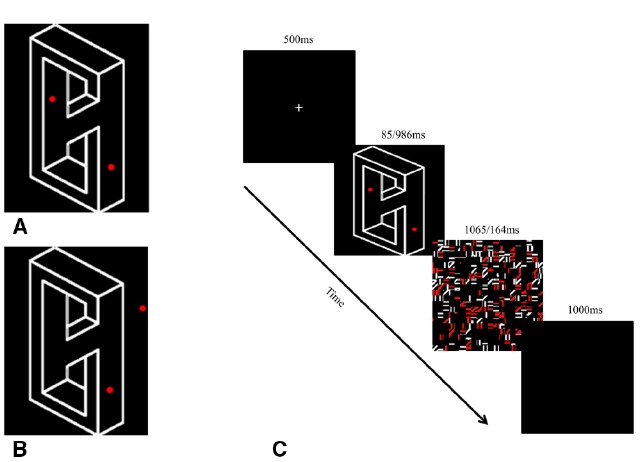
Stimuli and experimental design Experiment 2. On each trial, participants were asked to judge if the two circles are located inside the boundaries of the object (A), or whether one of the circles is located outside its boundaries (B). Exposure durations were manipulated to enable minimal processing of the object (85 ms) or full processing of the object (986 ms) (C).